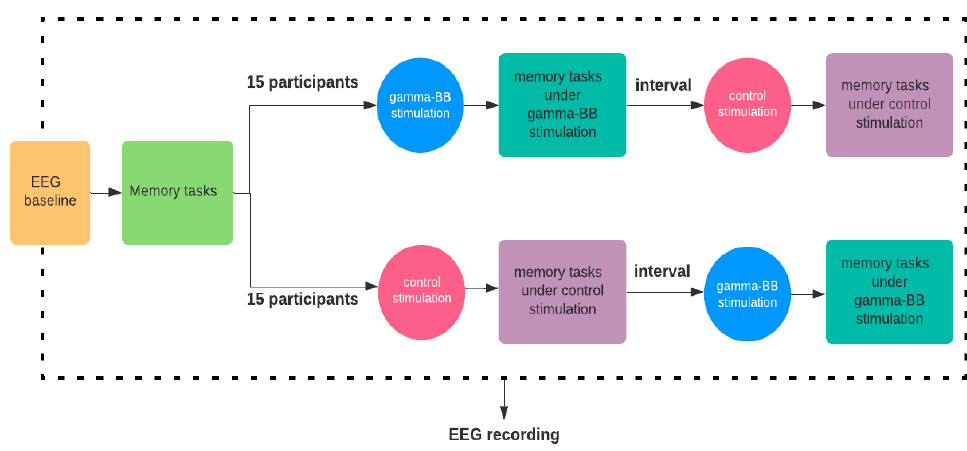
Figure 1. Diagram of the experimental protocol.